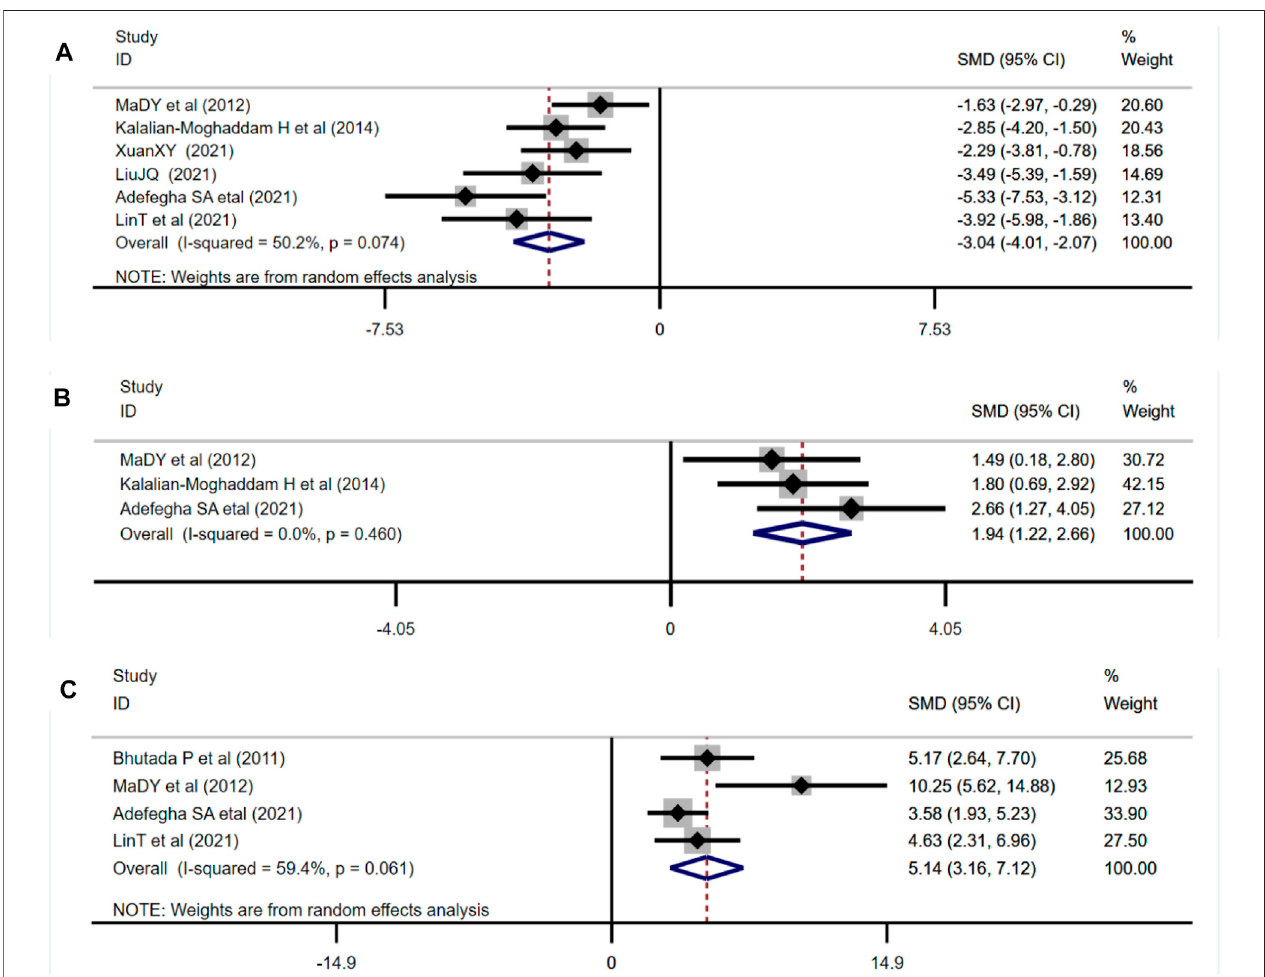
FIGURE 7 | Forest plot: effect of berberine on (A) MDA, (B) SOD, and (C) GSH.